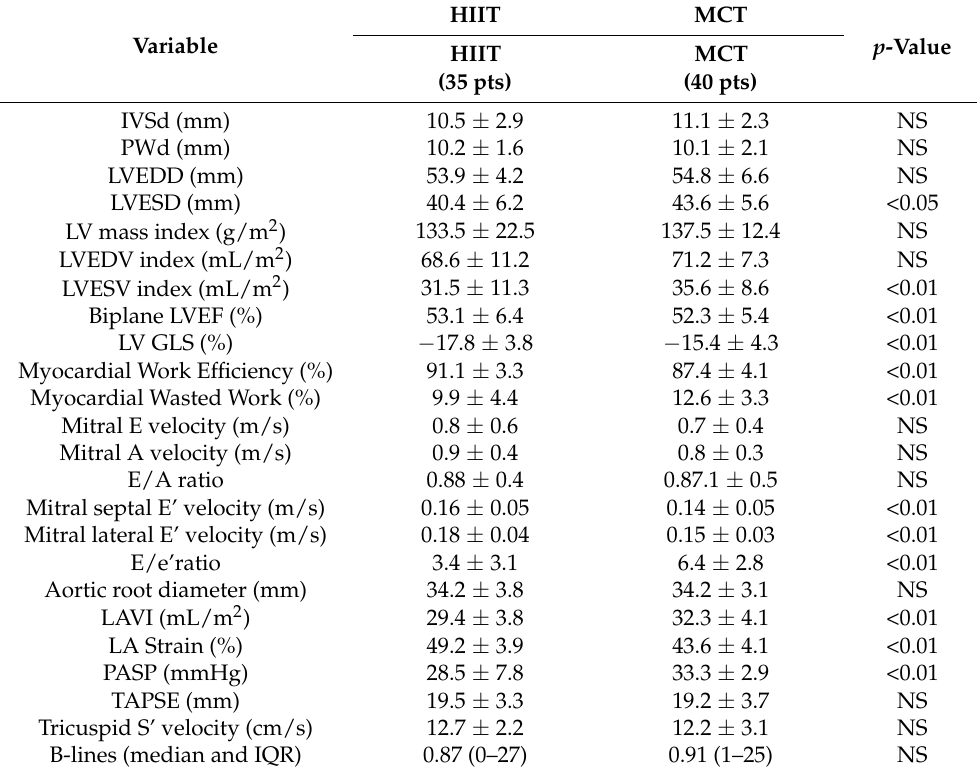
Table 4. Standard and strain echocardiographic measurements in ischemic patients after two different protocols of cardiac rehabilitation.